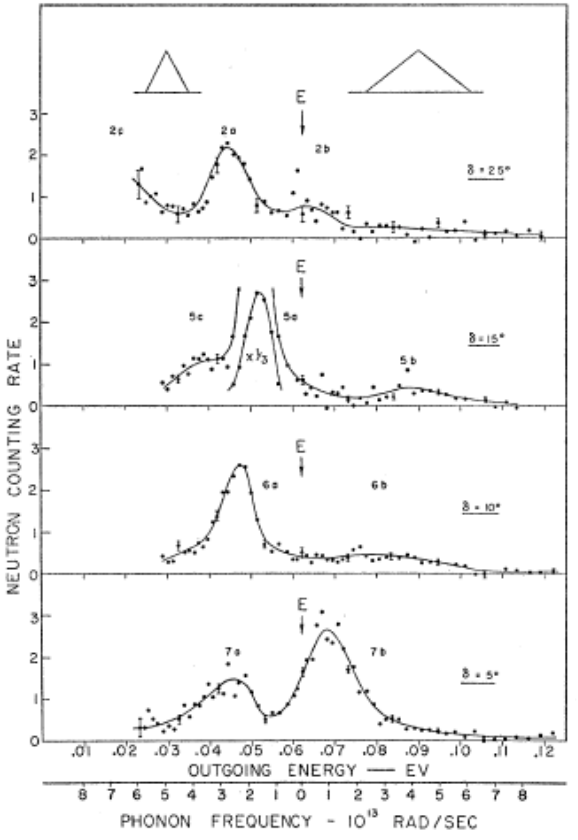
Figure 4. Typical energy distributions of neutrons inelastically scattered by an aluminum single crystal with the energy resolutions indicated by triangles. The count rate is plotted against the scattered energy in eV and the angular phonon frequency in 10 13 radians/sec. The incident energy E is indicated by the arrows. This figure is taken from Figure 1 of ref. [20]. Copyright by the American Physical Society.